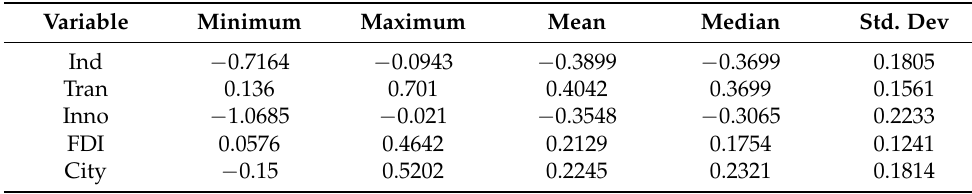
Table 6. Calculation results of the GWR